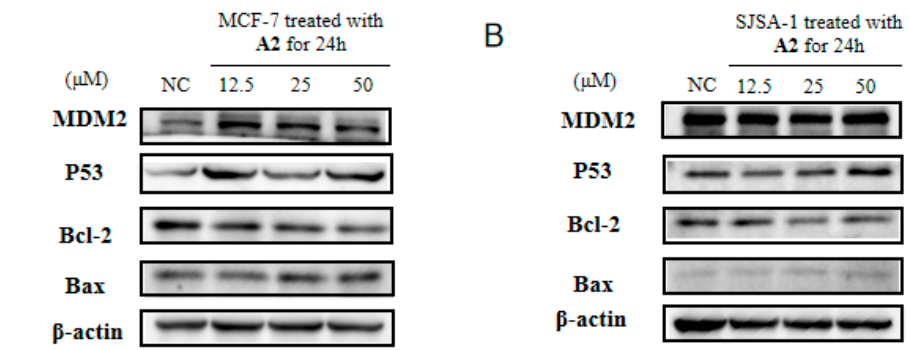
Figure 5. The effect of A2 on the relative protein expression. The protein expression in MCF-7 ( A ) and SJSA-1 ( B ) treated with A2 for 24 h with a concentration of 12.5, 25 and 50 µM. NC refers to 0.1% DMSO.